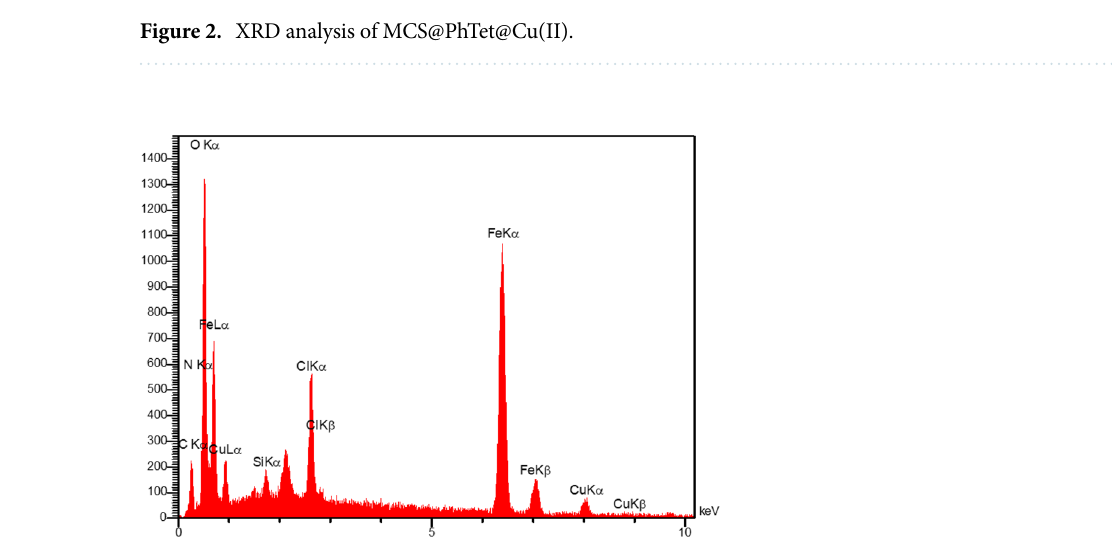
Figure 3. EDS spectrum of MCS@PhTet@Cu(II).